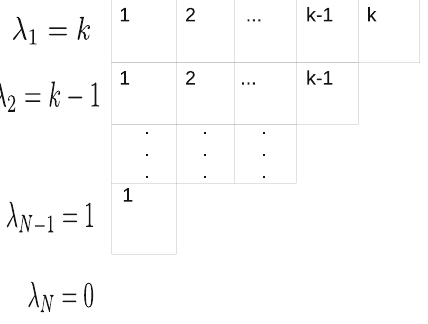
Fig. 5 A schematic form of the Young diagram corresponding to an arbitrary representation of SU ( N ) . λ i is equal to the number of boxes in the i -th row of the diagram. From here one can immediately infer that λ N =